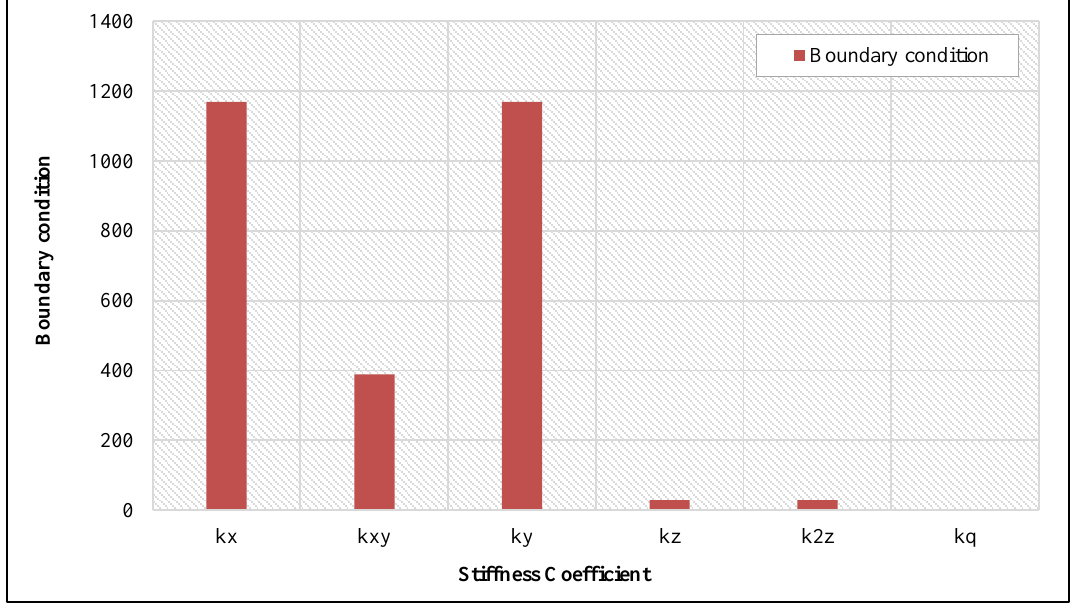
Figure 5. Stiffness coefficient for the CCCC plate boundary condition